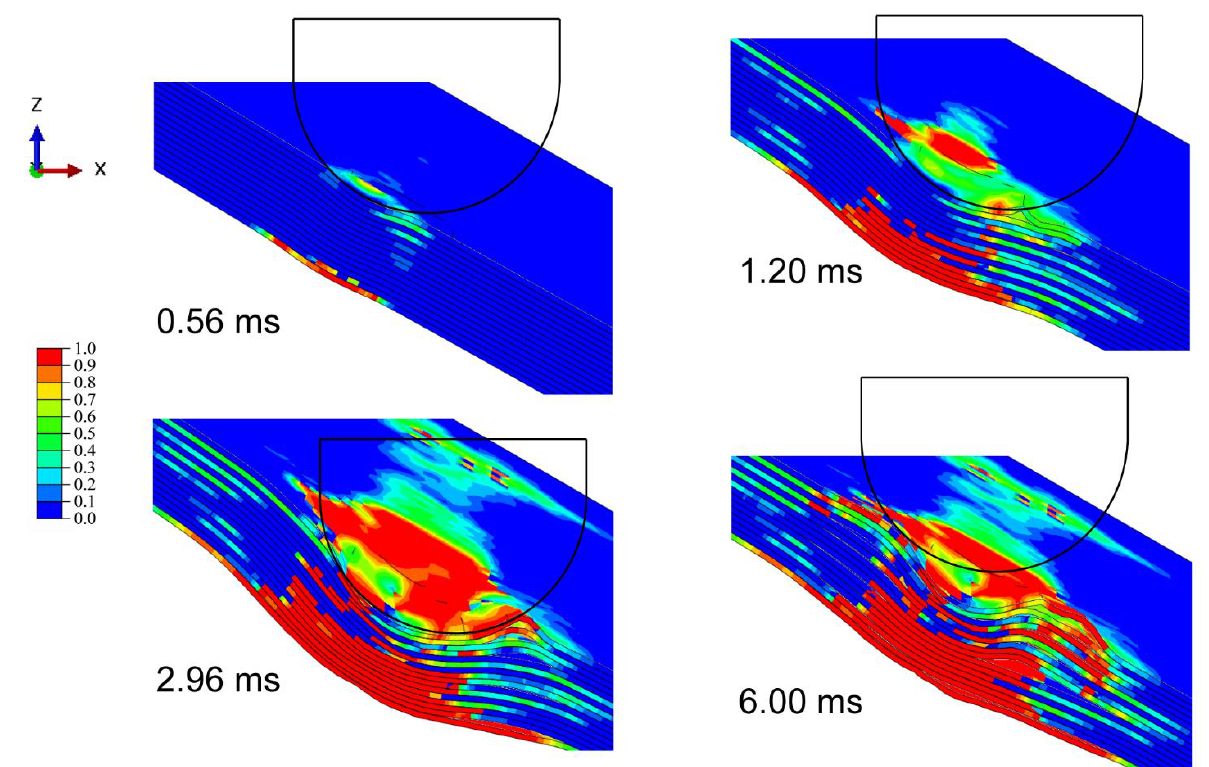
Figure 7. Evolution of matrix tensile damage with 30° impact angles under 20 J impact energy.